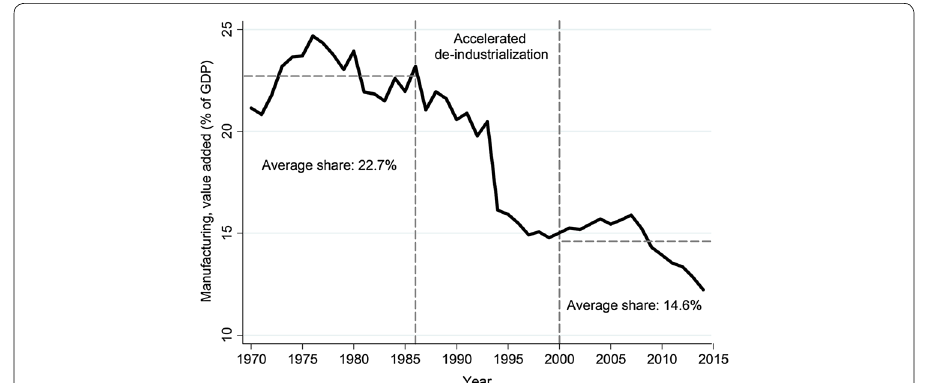
Fig. 1 Colombia: manufacturing share. Source : Author’s calculations based on World Bank